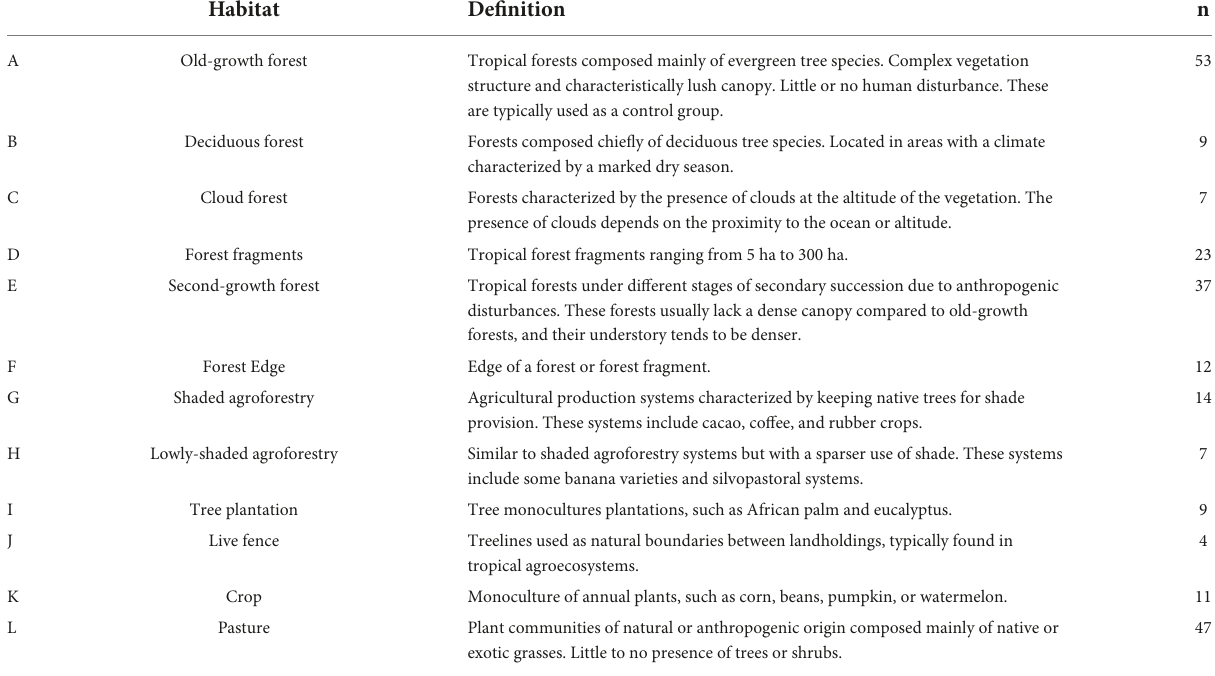
TABLE 1 Habitat types and sampling size. Habitat